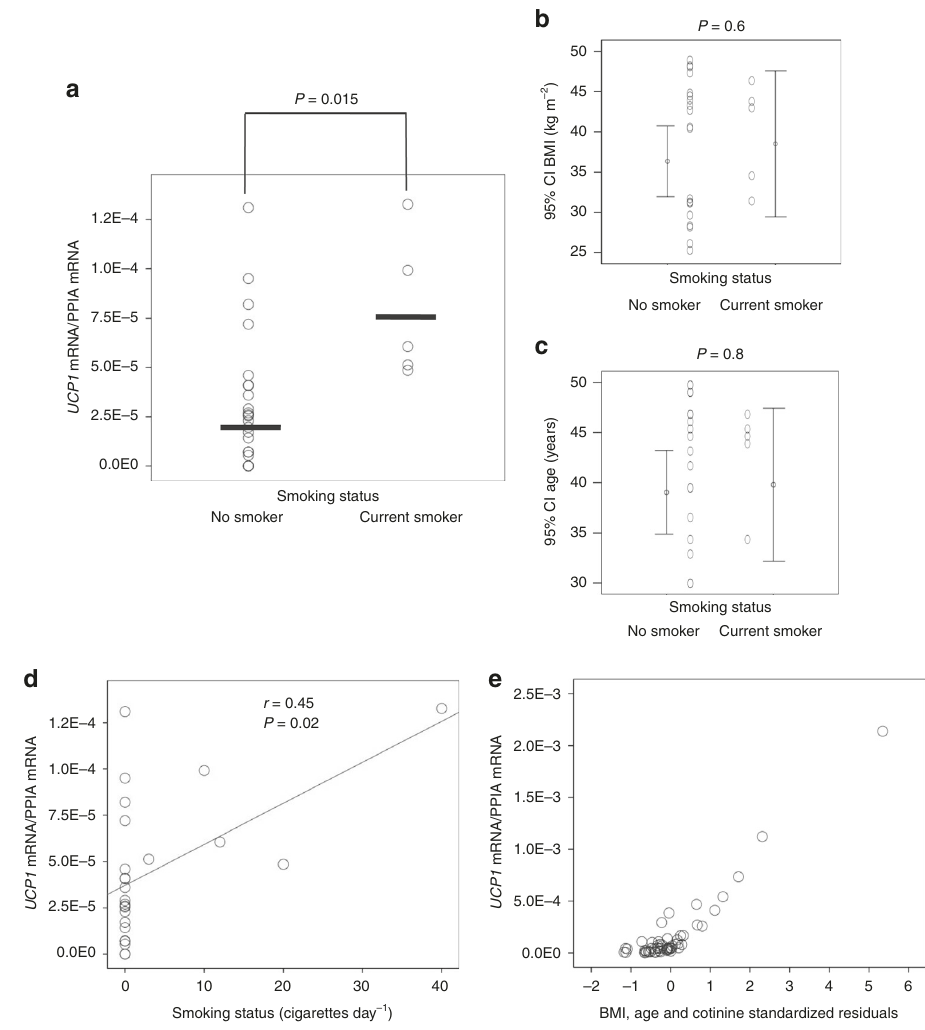
Fig. 6 Effect of smoking status on WAT browning. a – c UCP1 mRNA levels in sWAT, BMI and age in non-smokers or current smokers from cohort 1 (Non smoker n = 20, Smoker n = 5). Statistical analysis was performed with one factor ANOVA with post-hoc Bonferroni test; the samples represent biological replicates. Center values (black lines) represent median. d Bivariate correlation between sWAT UCP1 mRNA levels and cigarettes per day on current smokers from cohort 1 ( n = 25). This correlation was similar using parametric (Pearson, r = 0.46, P = 0.02) or non-parametric (Spearman, r = 0.45, P = 0.02) correlations. e Relationship between the BMI, age, and cotinine adjusted residuals of the multiple linear regression model and UCP1 gene expression in vWAT ( n = 56). The samples represent biological replicates. Source data are provided as a Source Data fi